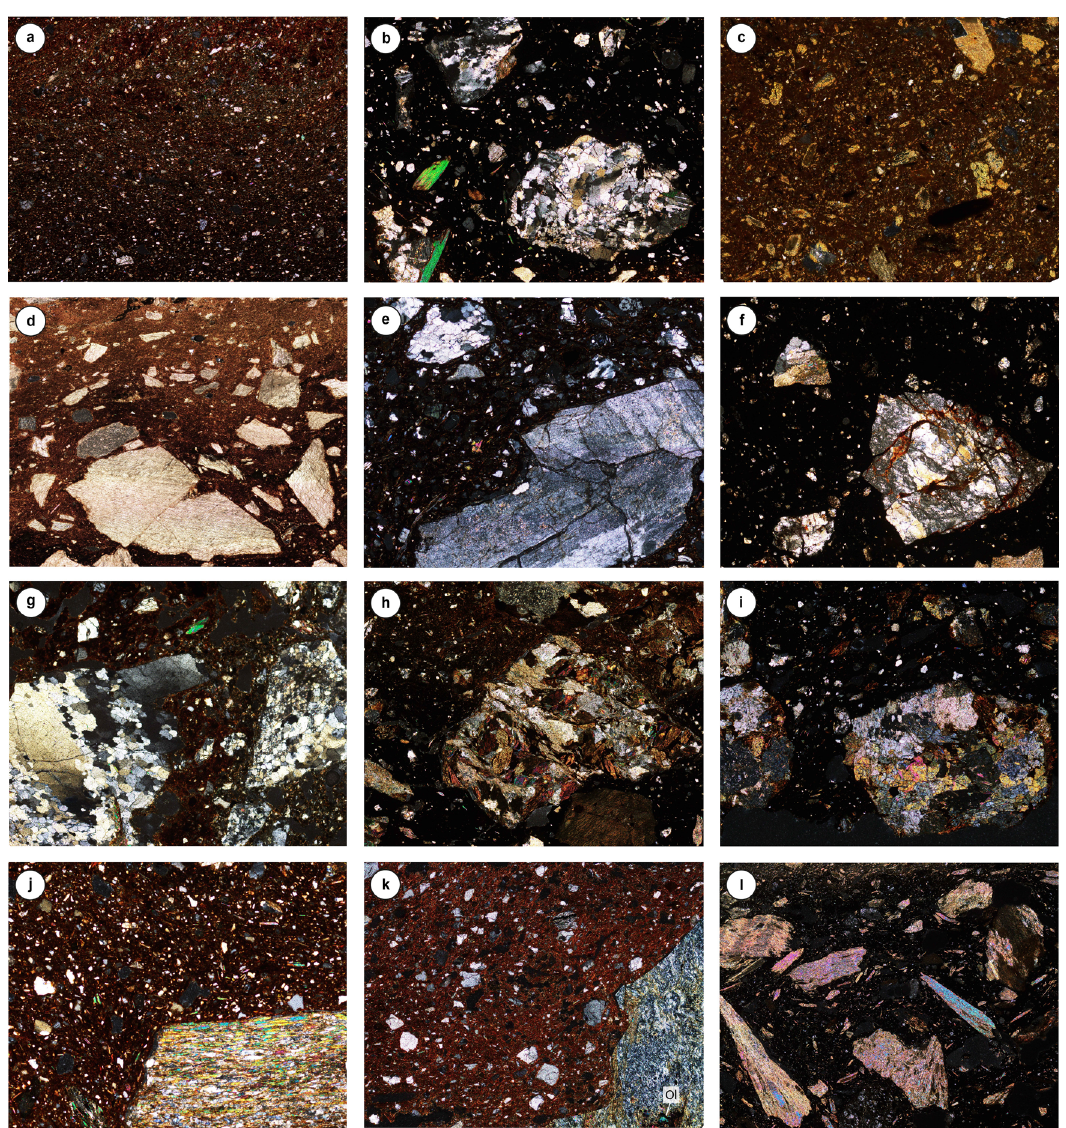
( BP06 ) ; ( h ) amphibolite ( SO09 ) ; ( i ) glaucophane schist ( SG03 ) ; ( j ) mica schist ( SM01 ) ; ( k ) chlorite schist ( SM02 ) ; and ( l ) talc schist ( SM03 ) . Image width 5.3